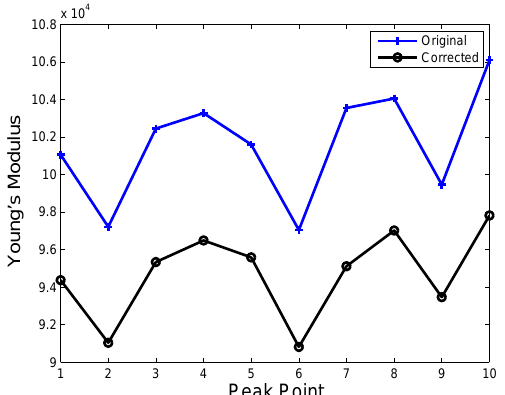
Figure 16. Young’s modulus (YM) for the ’no hard inclusion’ case. The blue curve denotes the YM by original force measured by sensor, and the black curve indicates the YM by compensated